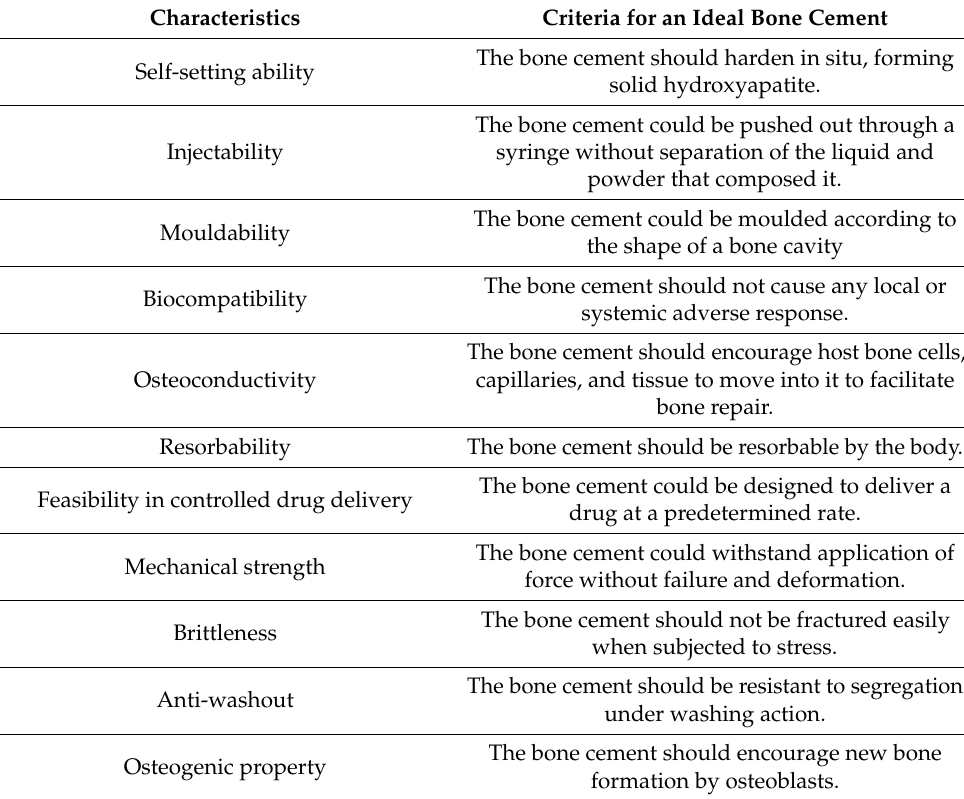
Table 1. The characteristics of ideal bone